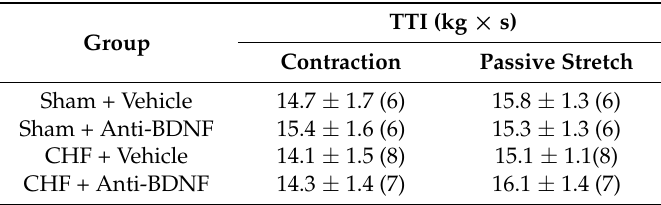
Table 2. Tension-time indexes for either static contraction or passive stretch in Sham + Vehicle, Sham